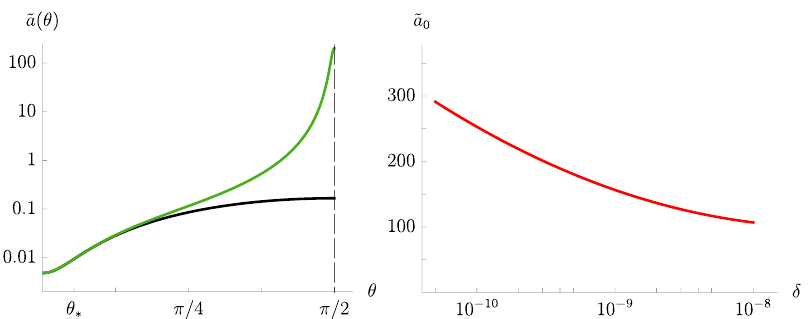
Figure 10 . Left: the function ~ a ( (cid:18) ) in the original Higgs-Dilaton theory (the lower curve) and in the modi(cid:12)ed theory with { chosen so that ~ a 0 = 200 (the upper curve). The angle (cid:18) (cid:3) corresponds to the scale of in(cid:13)ation (cid:24) M P =(cid:24) h . Right: the set of parameters (~ a 0 , (cid:14) ), for which eq. (5.14) is satis(cid:12)ed. Here we choose (cid:24) (cid:31) = 5 (cid:1) 10 (cid:0) 3 , (cid:24) h = 5 (cid:1) 10 3 and (cid:21) coinciding with the SM running Higgs self-coupling at NNLO with the central values of the top quark and Higgs masses (see (cid:12)gure 5). as the left panel of (cid:12)gure 10 demonstrates, the function ~ a ( (cid:18) ) is indistinguishable from its counterpart in the original theory at least up to the in(cid:13)ationary